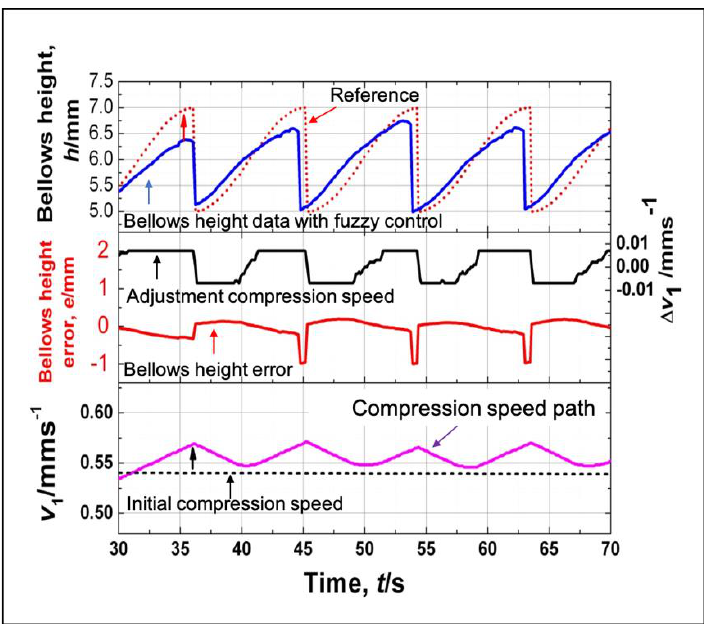
Figure 16. Bellows profile produced using a conventional fuzzy control.